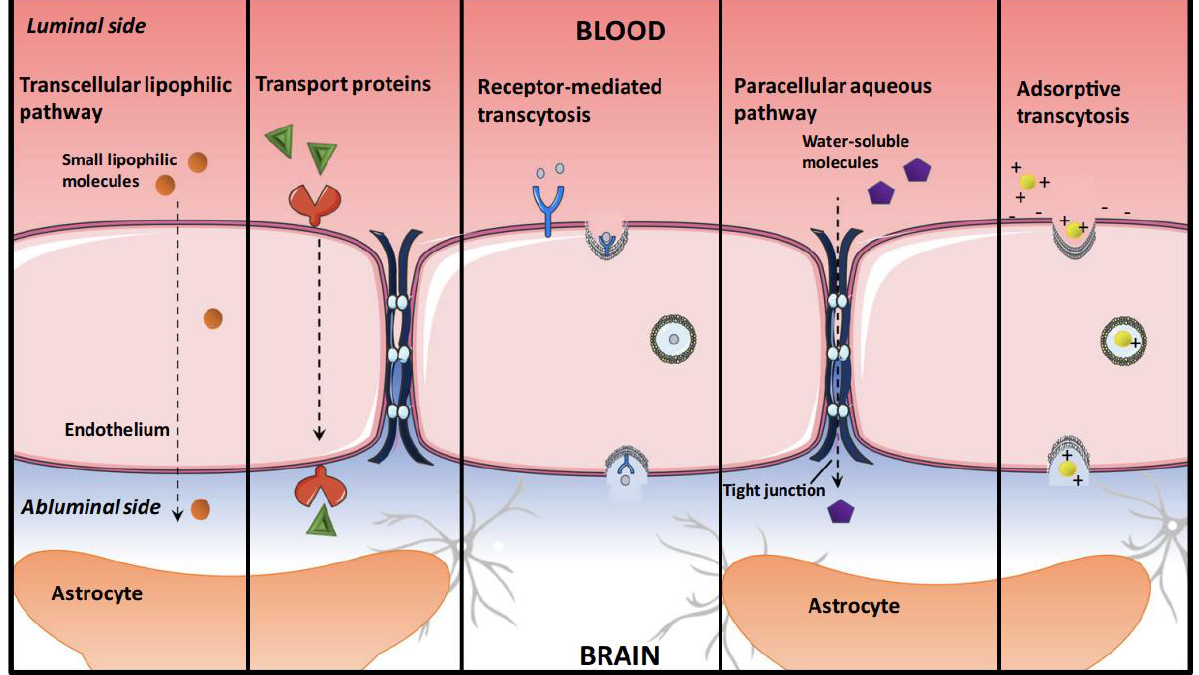
Figure 1. An overview of transport mechanisms across the blood – brain barrier (BBB), adapted from [43] , Springer, 2020.